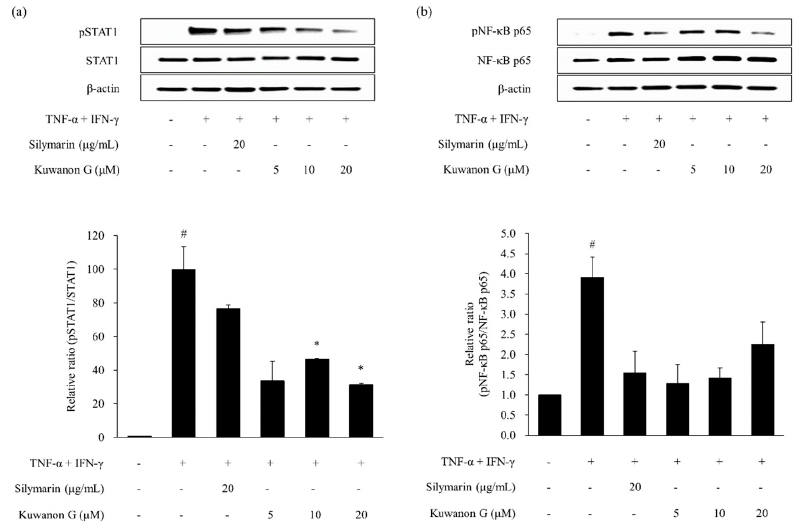
Figure 4. Effect of kuwanon G on TNF- α and IFN- γ -induced STAT1 ( a ) and NF- κ B p65 ( b ) phosphorylation in HaCaT keratinocytes. Expression of total and phosphorylated STAT1 (pSTAT1) and NF- κ B p65 (pNF- κ B p65) was determined by Western blotting. Silymarin was used as the positive control. Data are expressed as the mean ± SEM ( n = 2). # p < 0.05 versus vehicle control cells; * p < 0.05 versus TNF- α and IFN- γ -treated cells. Molecules 2018 , 23 , x FOR PEER REVIEW